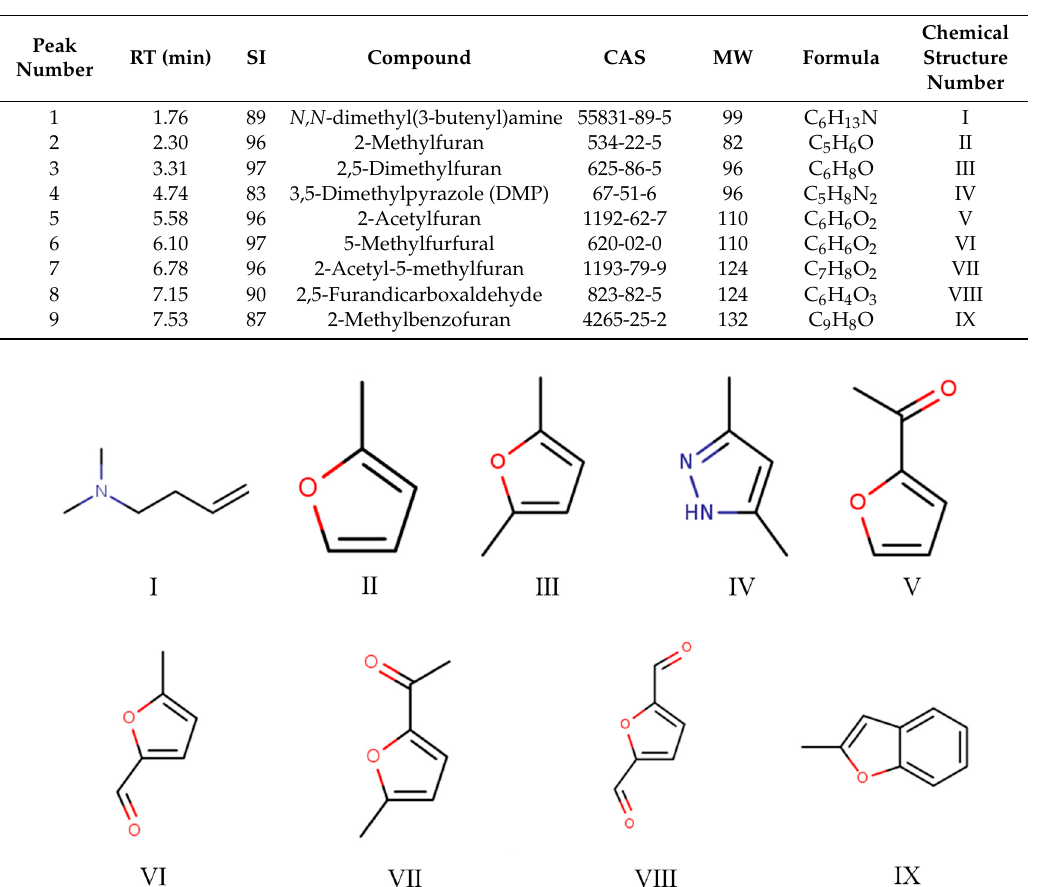
Figure 10. Chemical structure of the identified compounds in the evolved gas derived from the insoluble mass of cured SADP adhesive heated at 500 °C for 60 s.